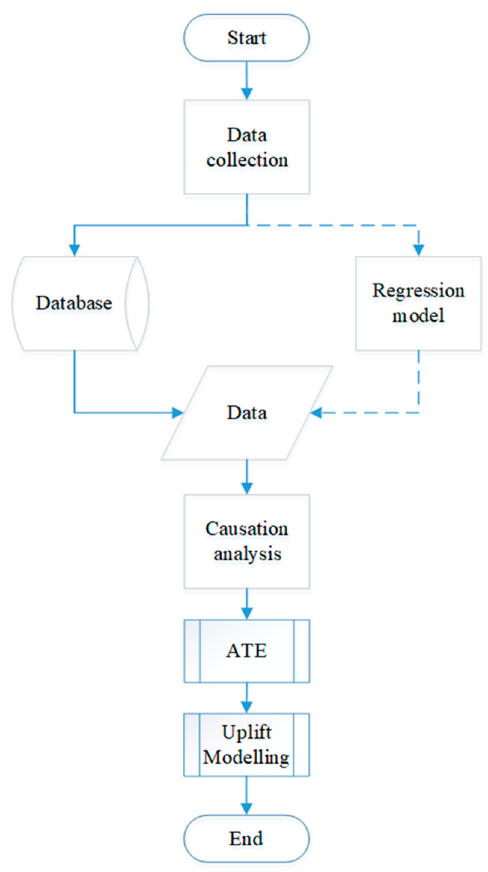
Figure 1. Framework for causation analysis of a pollutant exposure to the risk of developing a disease using machine learning techniques.